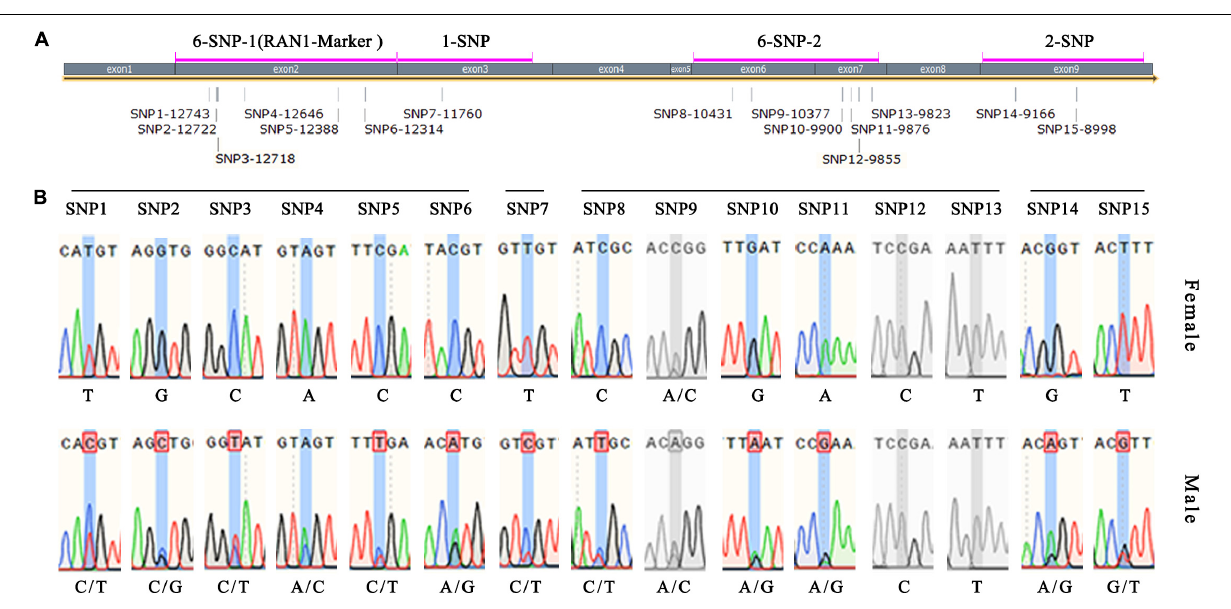
have this Chr01 AG , which we refer to as the conserved AG gene. Our study revealed that the conserved AG is also present in female and male fig trees ( FcAG-Pistil and FcAG-Gall ). In the “Dottato” genome, FcAG-Dottato was annotated but not localized to any chromosome.